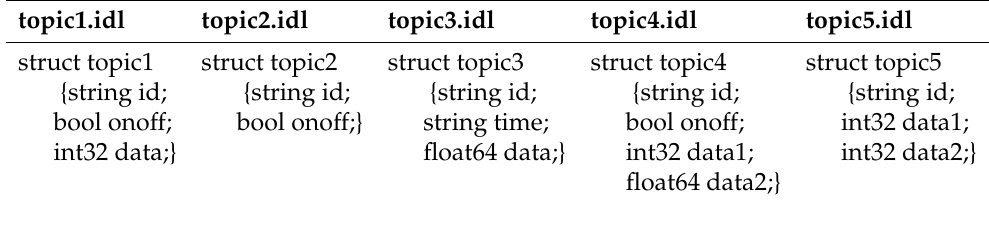
Table 1. General data